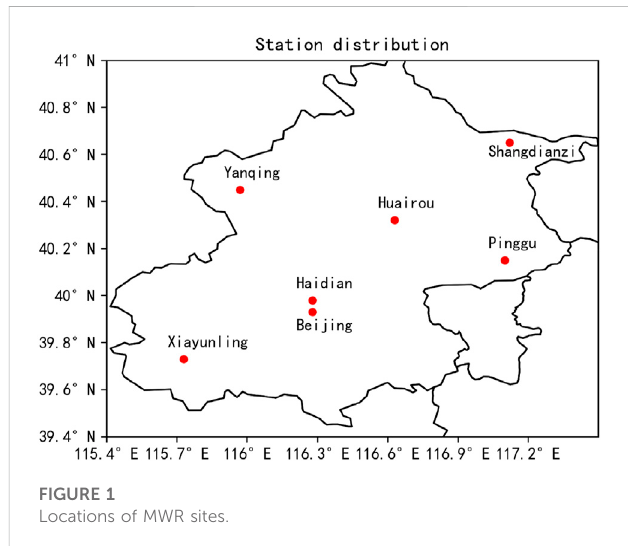
FIGURE 1 Locations of MWR